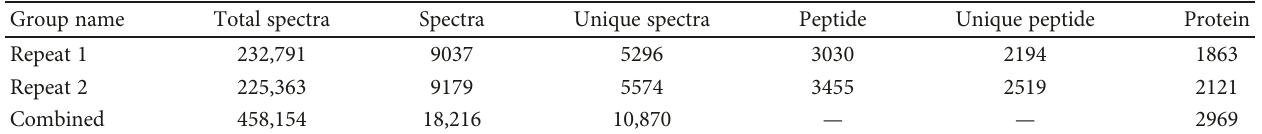
Table 3: Statistics of proteins identi fi ed by